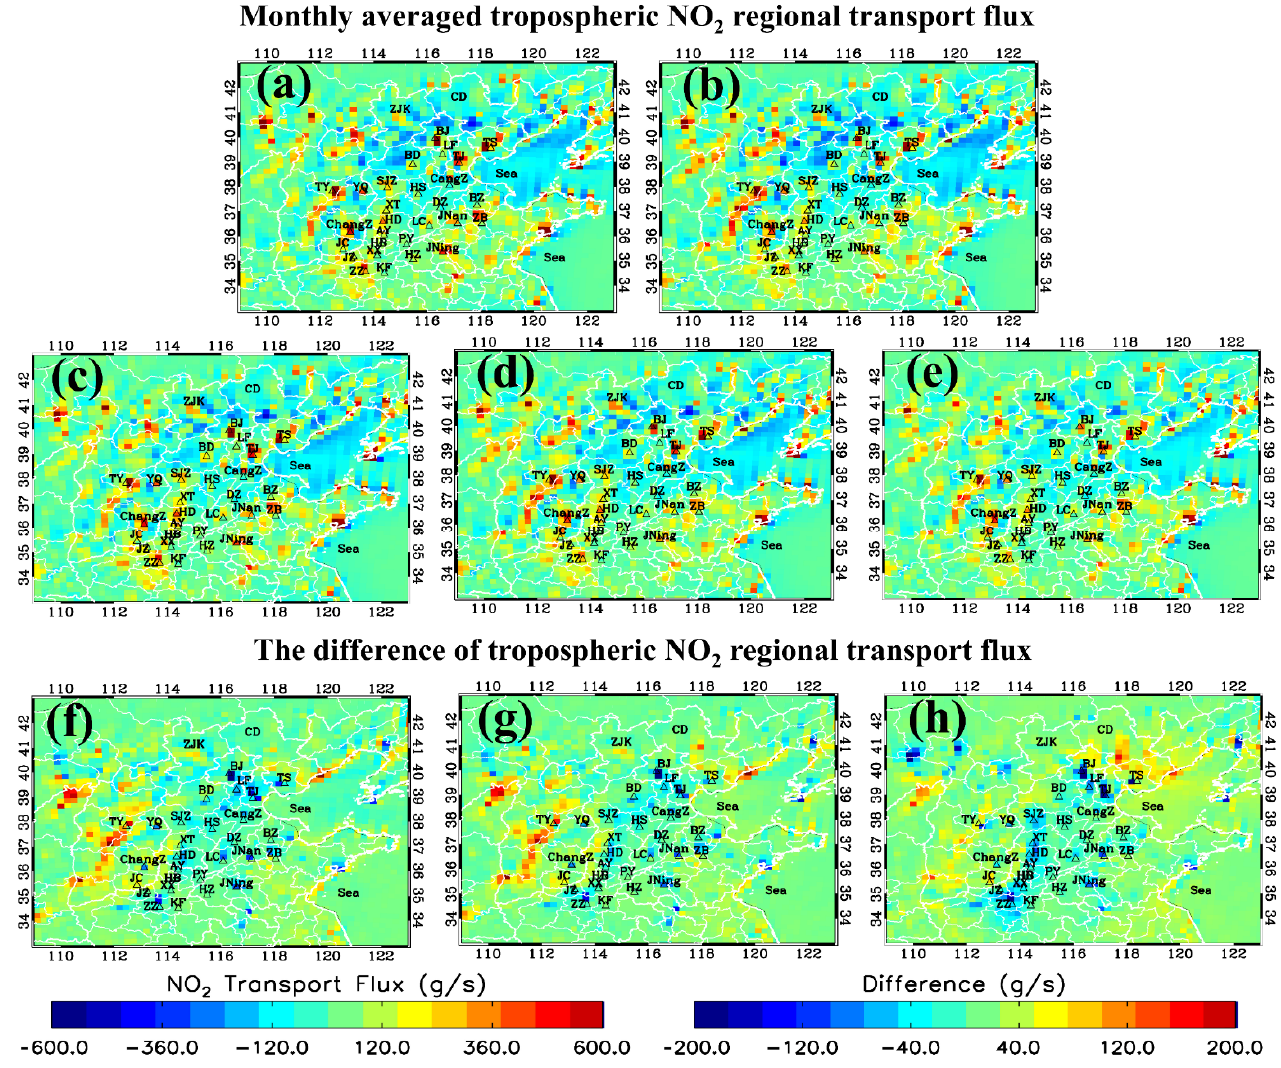
Figure 5. Four-month averaged tropospheric NO 2 regional transport flux (region with positive value indicates source of NO 2 , and negative value indicates sink of NO 2 ) derived from MEIC-2017, top-down NO X emissions, and their differences. ( a ) Calculated NO 2 flux in W_2018 with MEIC-2017 inventory. ( b ) Same as ( a ) except with top-down W_2018 inventory. ( c ) Calculated NO 2 flux in W_2019 with MEIC-2017 inventory. ( d ) Same as ( c ) except with top-down W_2018 inventory. ( e ) Same as ( c ) except with top-down W_2019 inventory. ( f ) Difference between ( a ) and ( b ) (( b ) minus ( a )). ( g ) Difference between ( c ) and ( d ) (( d ) minus ( c )). ( h ) Difference between ( c ) and ( e ) (( e ) minus ( c )).